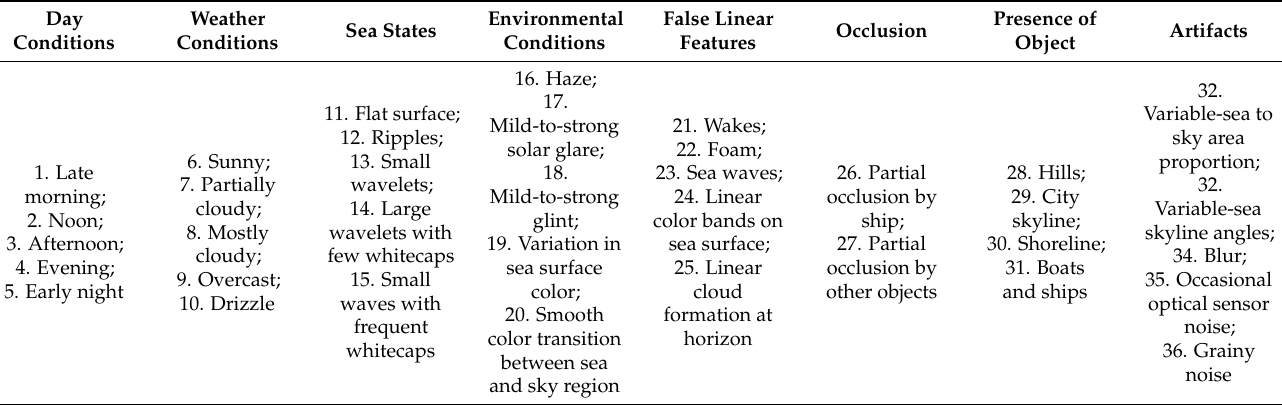
Table 4. Features list of proposed